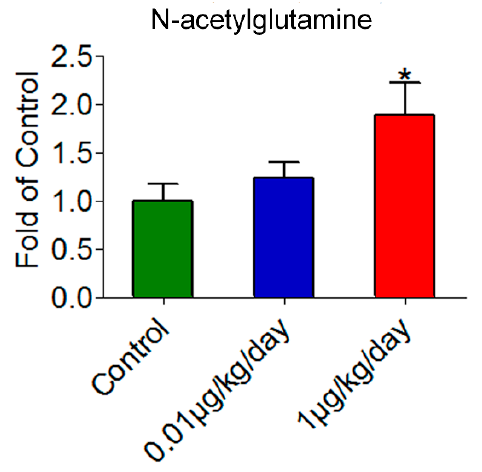
Figure 6. Relative level of N-acetylglutamine in the livers of mice treated with low dosages of OP. The relative level of N-acetylglutamine was increased significantly at the OP dosage of 1 μ g/kg/day. Significance level: * p < 0.05 compared with